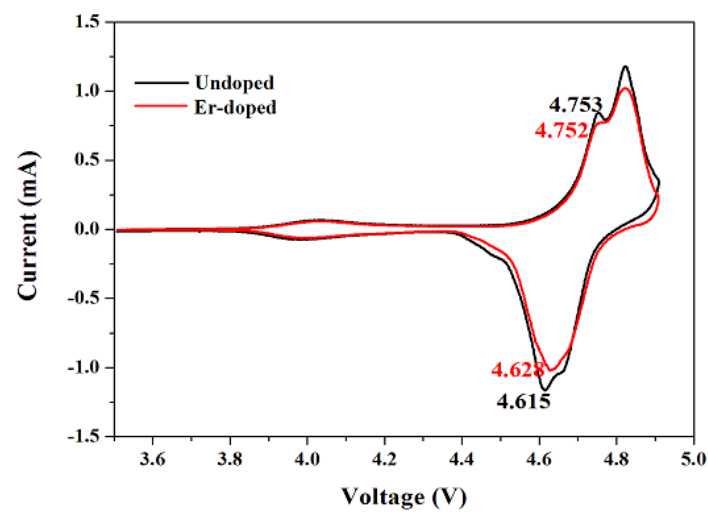
Figure 9. Cyclic voltammograms of the LiNi 0.5 Mn 1.5 O 4 and Er-doped LiNi 0.5 Mn 1.5 O 4 in the range of